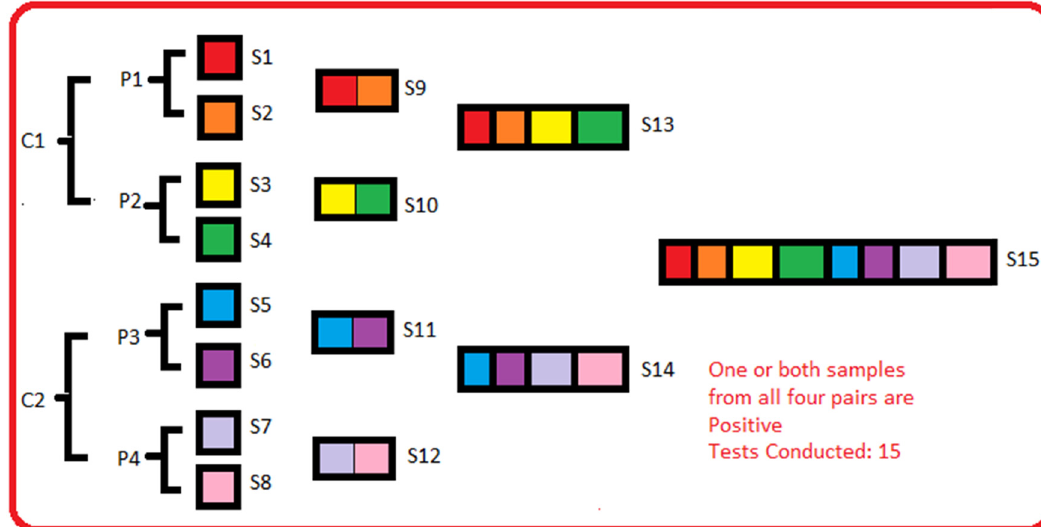
Figure 8: Fifteen tests to be performed to test eight